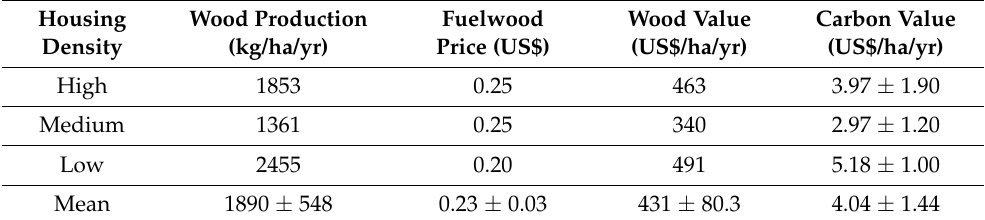
Table 3. Annual value of fuelwood produced in sampled green